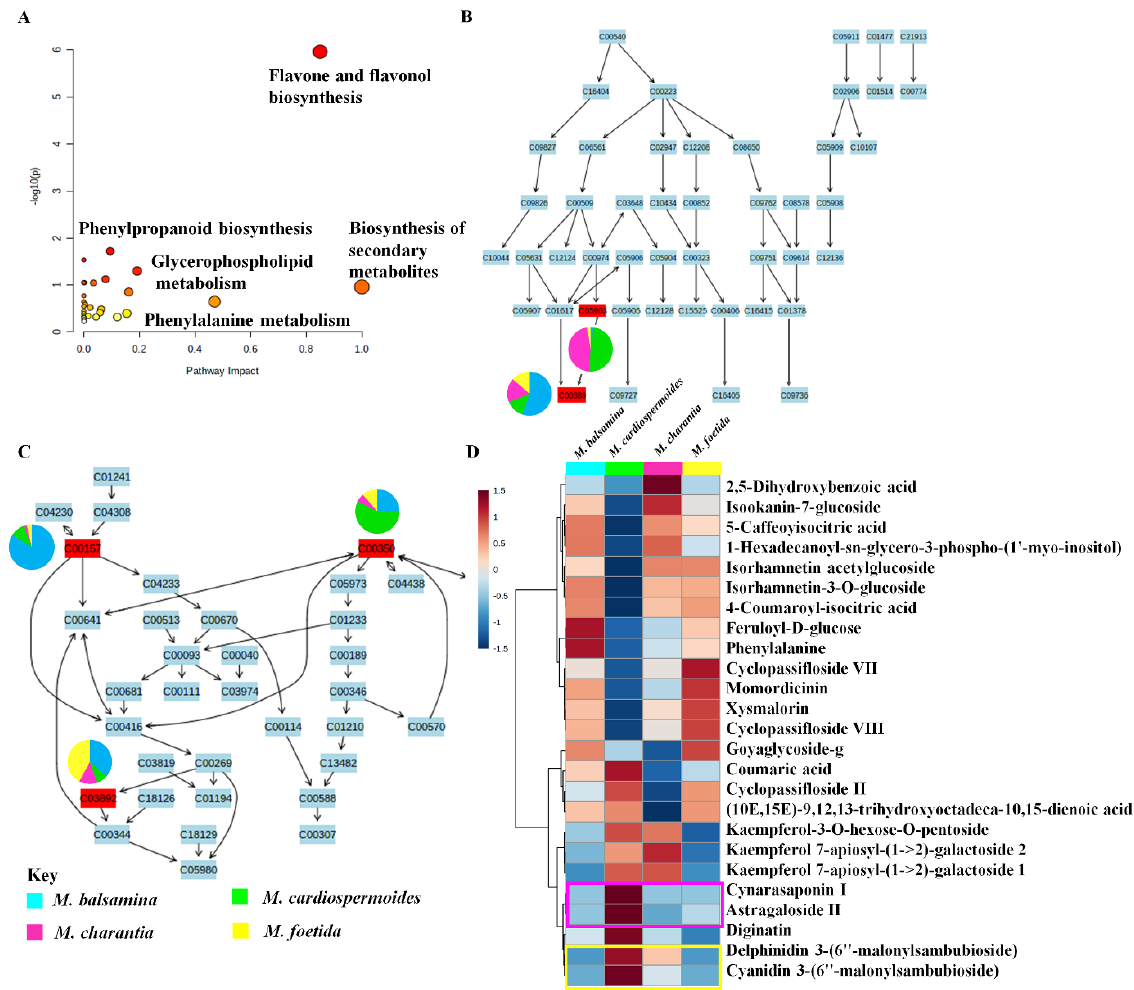
Figure 3. A summary of the metabolism pathways identified in Momordica species ( A ). An indication of the flavonoid biosynthesis pathway ( B ). The glycerophospholipid pathway ( C ). The relative quantification of some metabolites identified across the four Momordica species, highlighted in yellow are the anthocyanin derivatives abundant in M. cardiospermoides and in purple some saponins that are abundant in M. cardiospermoides and M. charantia ( D ).